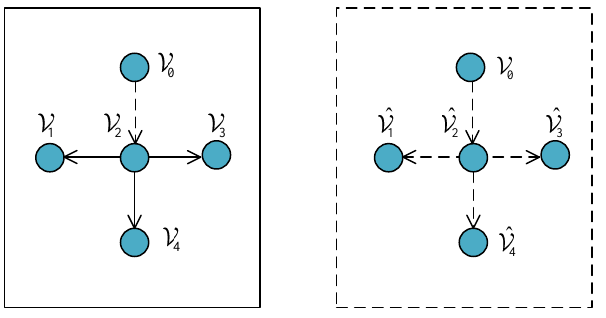
Figure 1. The communication topology in the virtual-structure-like